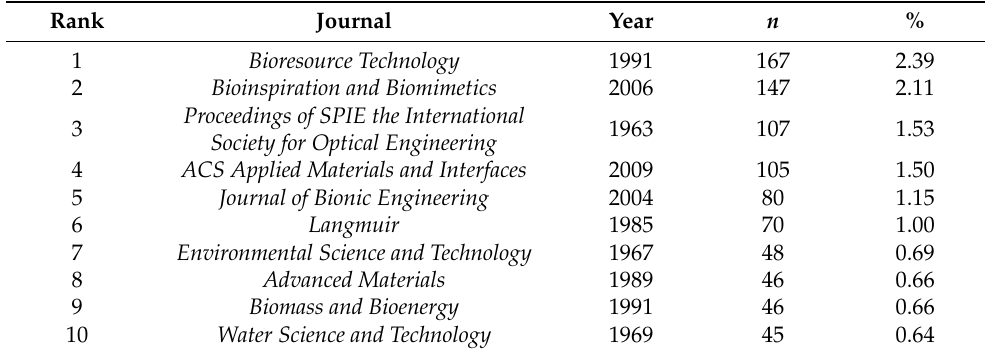
Table 1. The top ten journals, in terms of year of official foundation, number of papers ( n ) published from 1950 to 2020 on biomimicking along with their relative frequency (%).